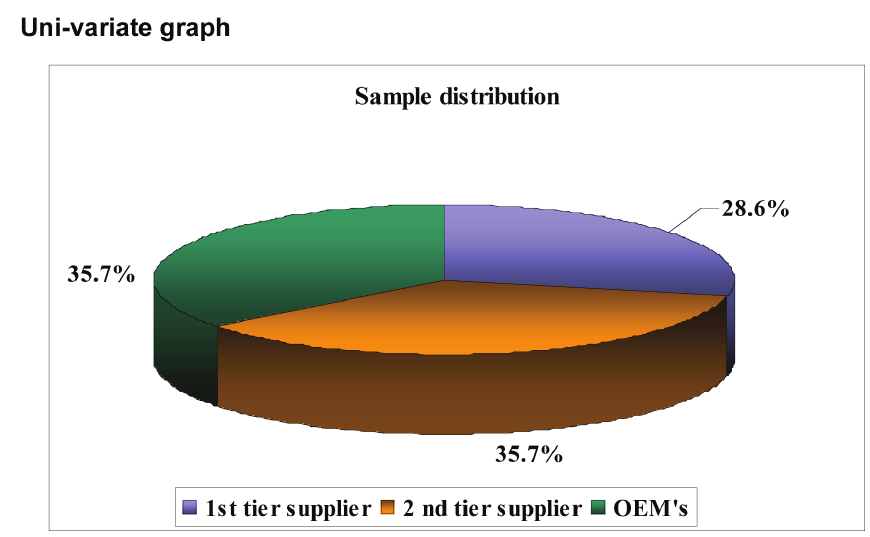
Figure 5: Pie graph with 3D visual effect for the sample distribution Measuring methods of